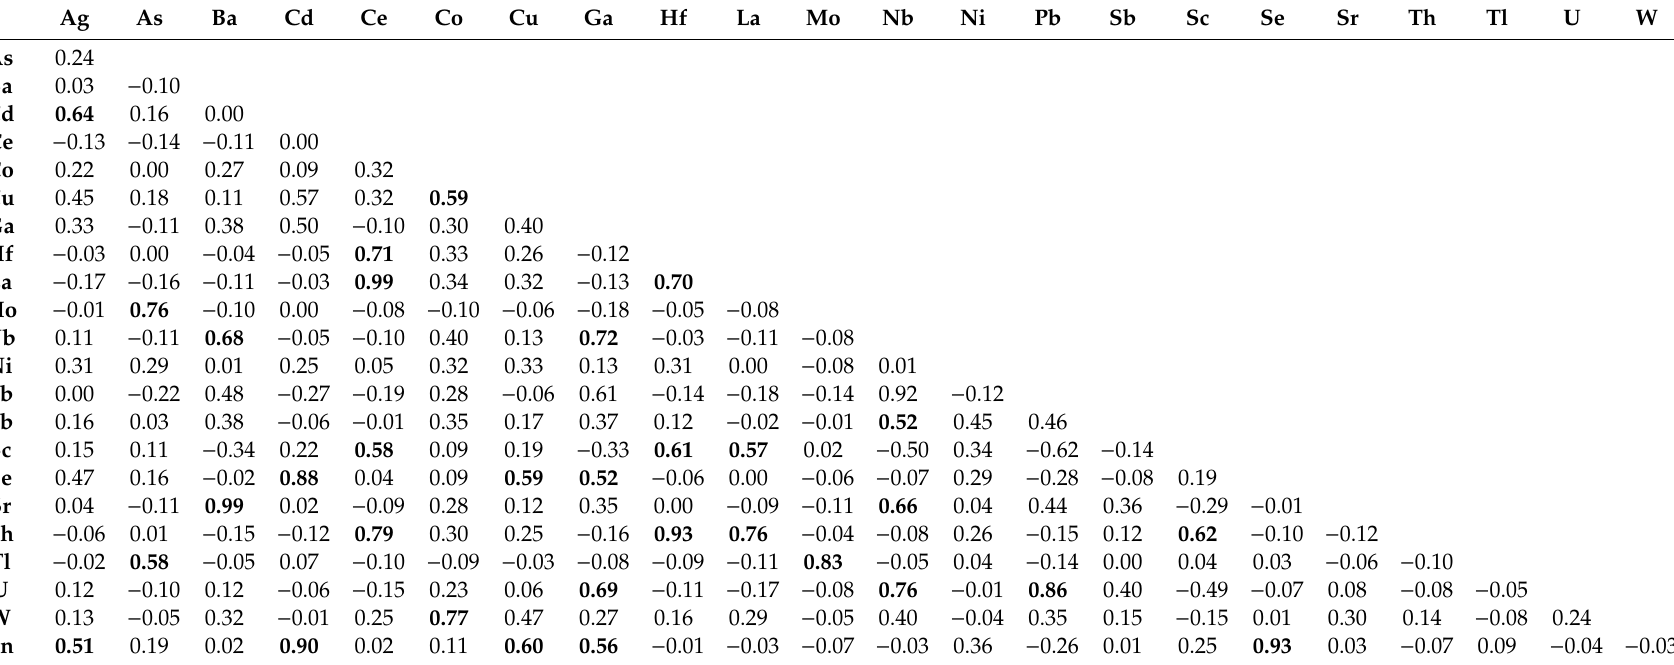
Table 3. Pearson’s correlation coe ffi cients of selected elements for the bulk-rock samples from Zn-Pb (MVT) deposits in